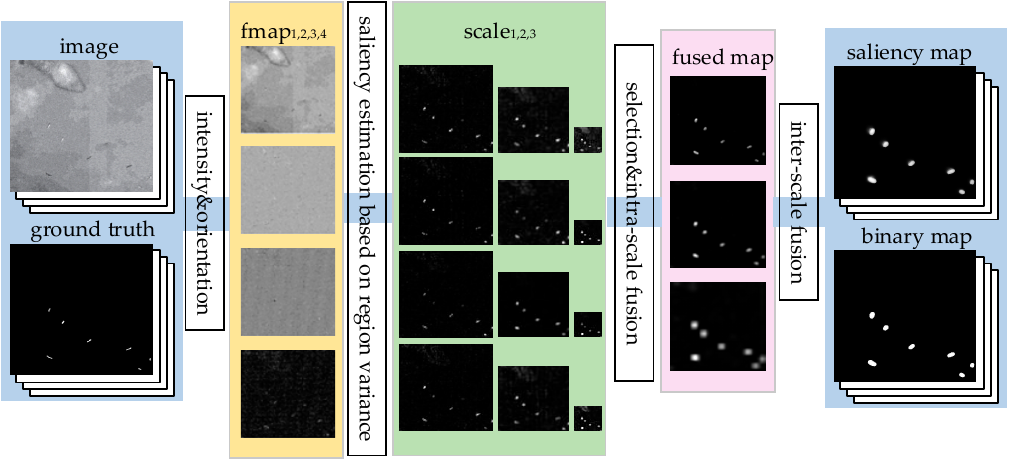
Figure 3. Proposed algorithm from input image ( left ) to saliency map ( right ). For visibility, feature maps, rarity maps, and saliency maps are normalized to [0,1].